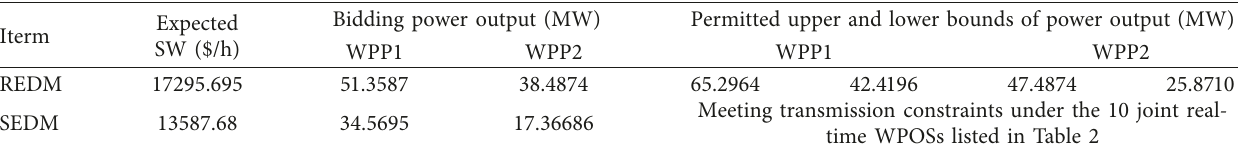
Table 8: Calculating results of expected SW, bidding power outputs, and permitted (predicted) real-time upper and lower bounds of power outputs considering different dispatch models.